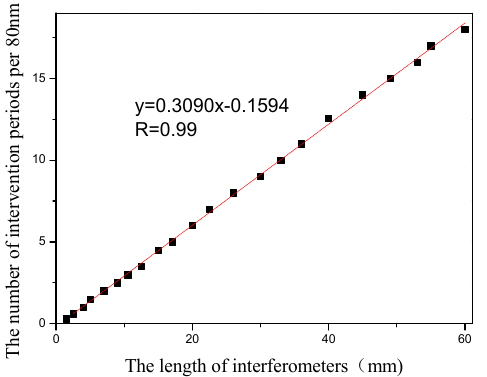
Figure 3. Interferometric spectra of sensors with different lengths.